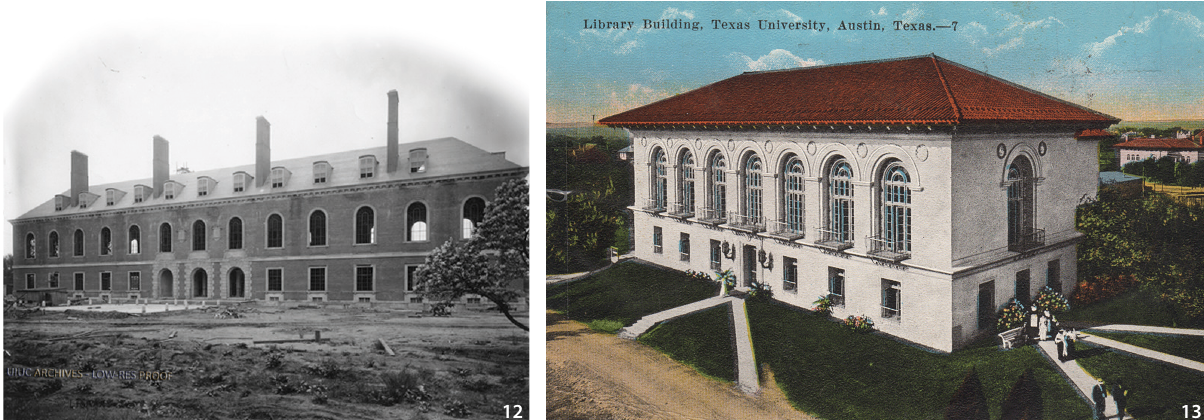
Figure 12 University of Illinois Library, under construction, Urbana, Illinois, 1927 (Source: University of Illinois Archives, Urbana, Illinois). Figure 13 University of Texas Library, Austin, Texas, c 1910 (Source: University of Texas Archives, Austin,